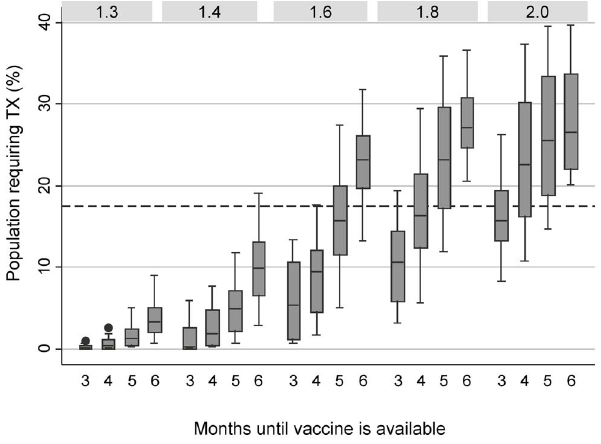
Figure 2. Projected range of treatment required depending on the transmissibility of the virus. The proportion of the Canadian population expected to require antiviral treatment for different combinations of model scenarios in the presence of a safe and effective pandemic vaccine when the reproductive number of the virus ranges from 1.3 to 2.0 [1.4 for seasonal influenza, 1.6–2.0 historical pandemic range]. The dashed line represents the proportion of the Canadian population who would be able to be treated by our existing stockpile (17.5%).